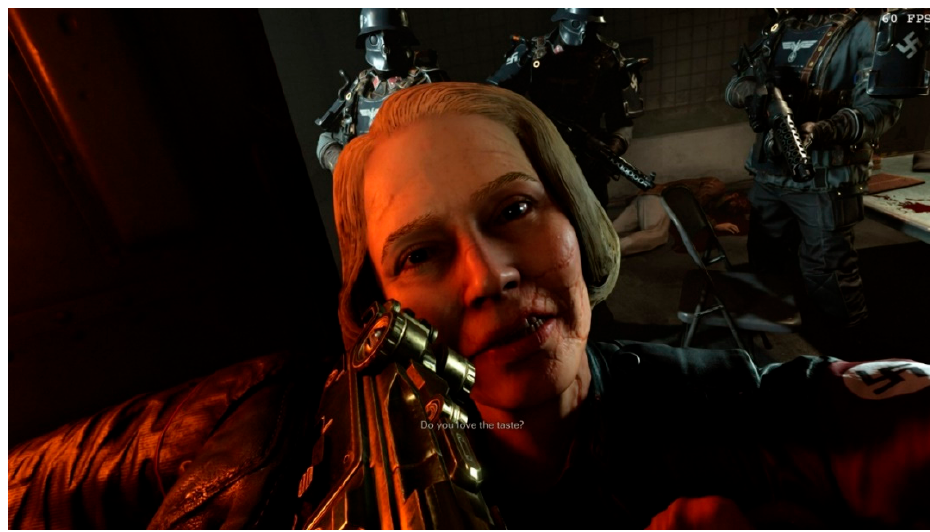
Figure 4. Irene Engel’s sexually charged assault on BJ Blazkowicz.